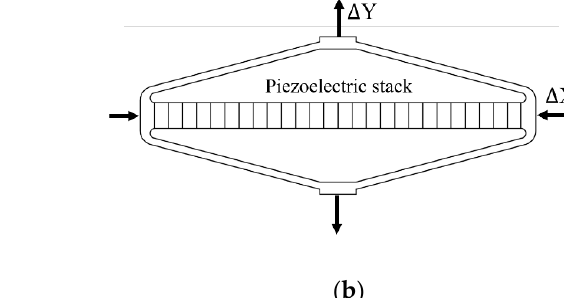
Figure 6. The output is perpendicular to the input: ( a ) rhombus type with rigid arms and flexure hinge; ( b ) bridge type with thin arms.